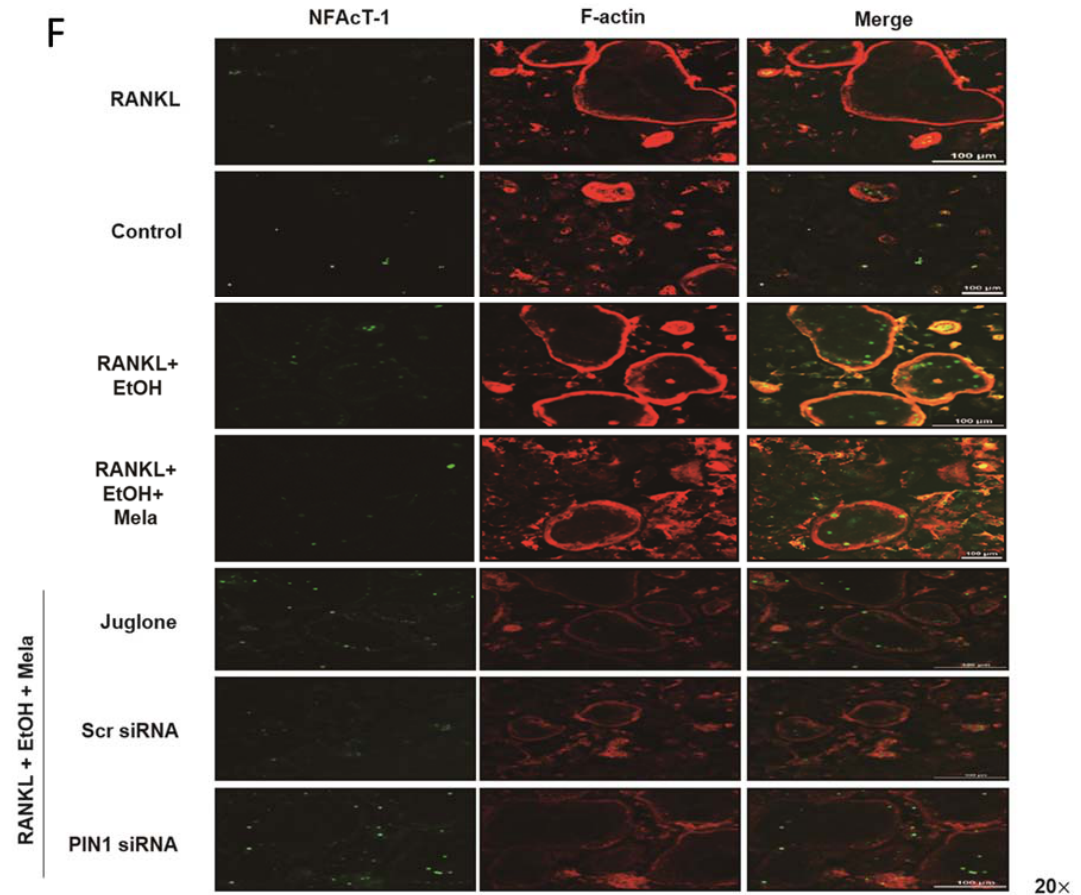
Figure 7. Indirect effects of melatonin on EtOH-induced osteoclastic differentiation in PDLCs and cementoblasts. Cells are pretreated with juglone (50 nM) or PIN1 siRNA (30 nM) and then incubated with melatonin (100 µ M) and EtOH (25 mM) for 3 days ( A ) in PDLCs and cementoblasts and conditioned medium (CM) were prepared. The bone-marrow derived macrophage (BMM) cells were incubated with M-CSF (10 ng/mL) and RANKL (50 ng/mL) or 20% CM collected from PDLCs and cementoblasts. After 48 h of culture, the cells were fixed and osteoclast-like cells were identified by TRAP staining; ( B , C ) Representative pictures of TRAP staining ( B ) and actin ring ( C ); The numbers of osteoclasts per well were counted ( D ); mRNA expression of osteoclast-specific marker genes was assessed by RT-PCR ( A , E ). Representative immunofluorescence of NFATc1 and F-actin expression ( F ) for CM from PDLCs. Similar data were obtained from three independent experiments. Red color is for F-actin. Green color is for NFATc1. Merged color is for F-actin & NFATc1. NFATc1 expression was examined by RT-PCR ( E ) and immunofluorescence ( F ). * statistically significant difference compared to the control groups ( p < 0.05). # statistically significant difference in each group.